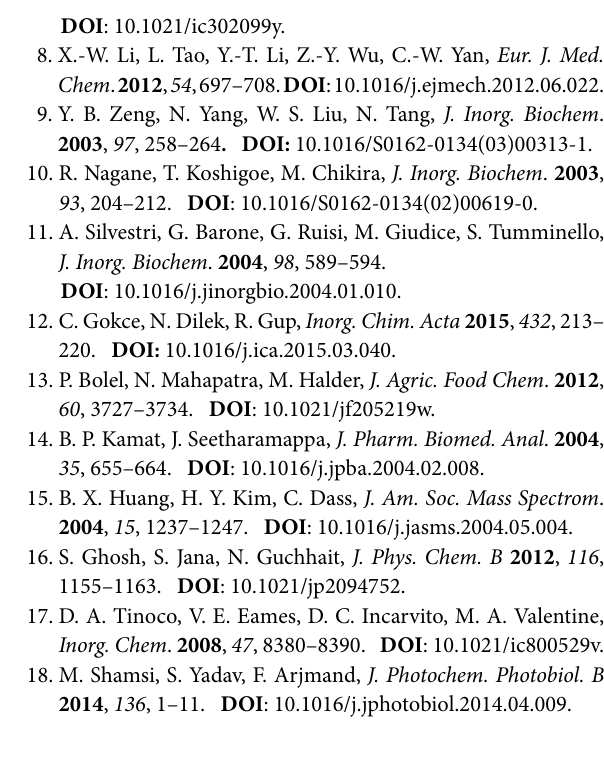
Fig. 11 : (a) Molecular docked model of FeL with DNA (b) specific interaction of FeL with DNA(c) Molecular docked model of FeL with BSA (d) specific interaction of FeL with